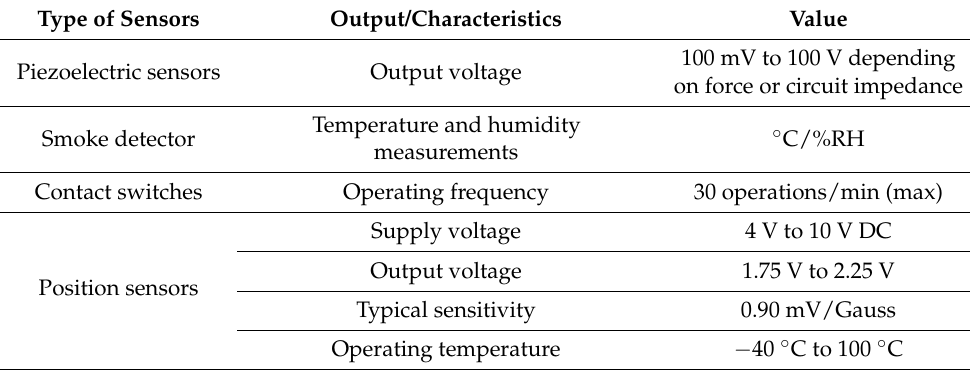
Table 2. Sensors—technical specifications.